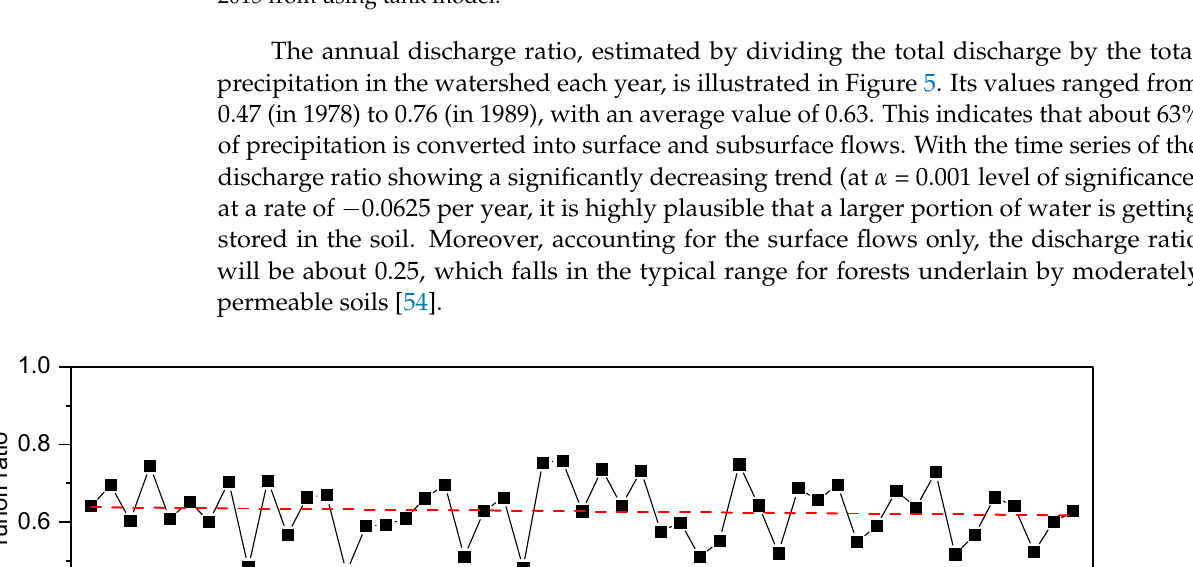
Figure 4. Observed and calculated amounts of flow during the wet season (May–October) in year 2015 from using tank model.